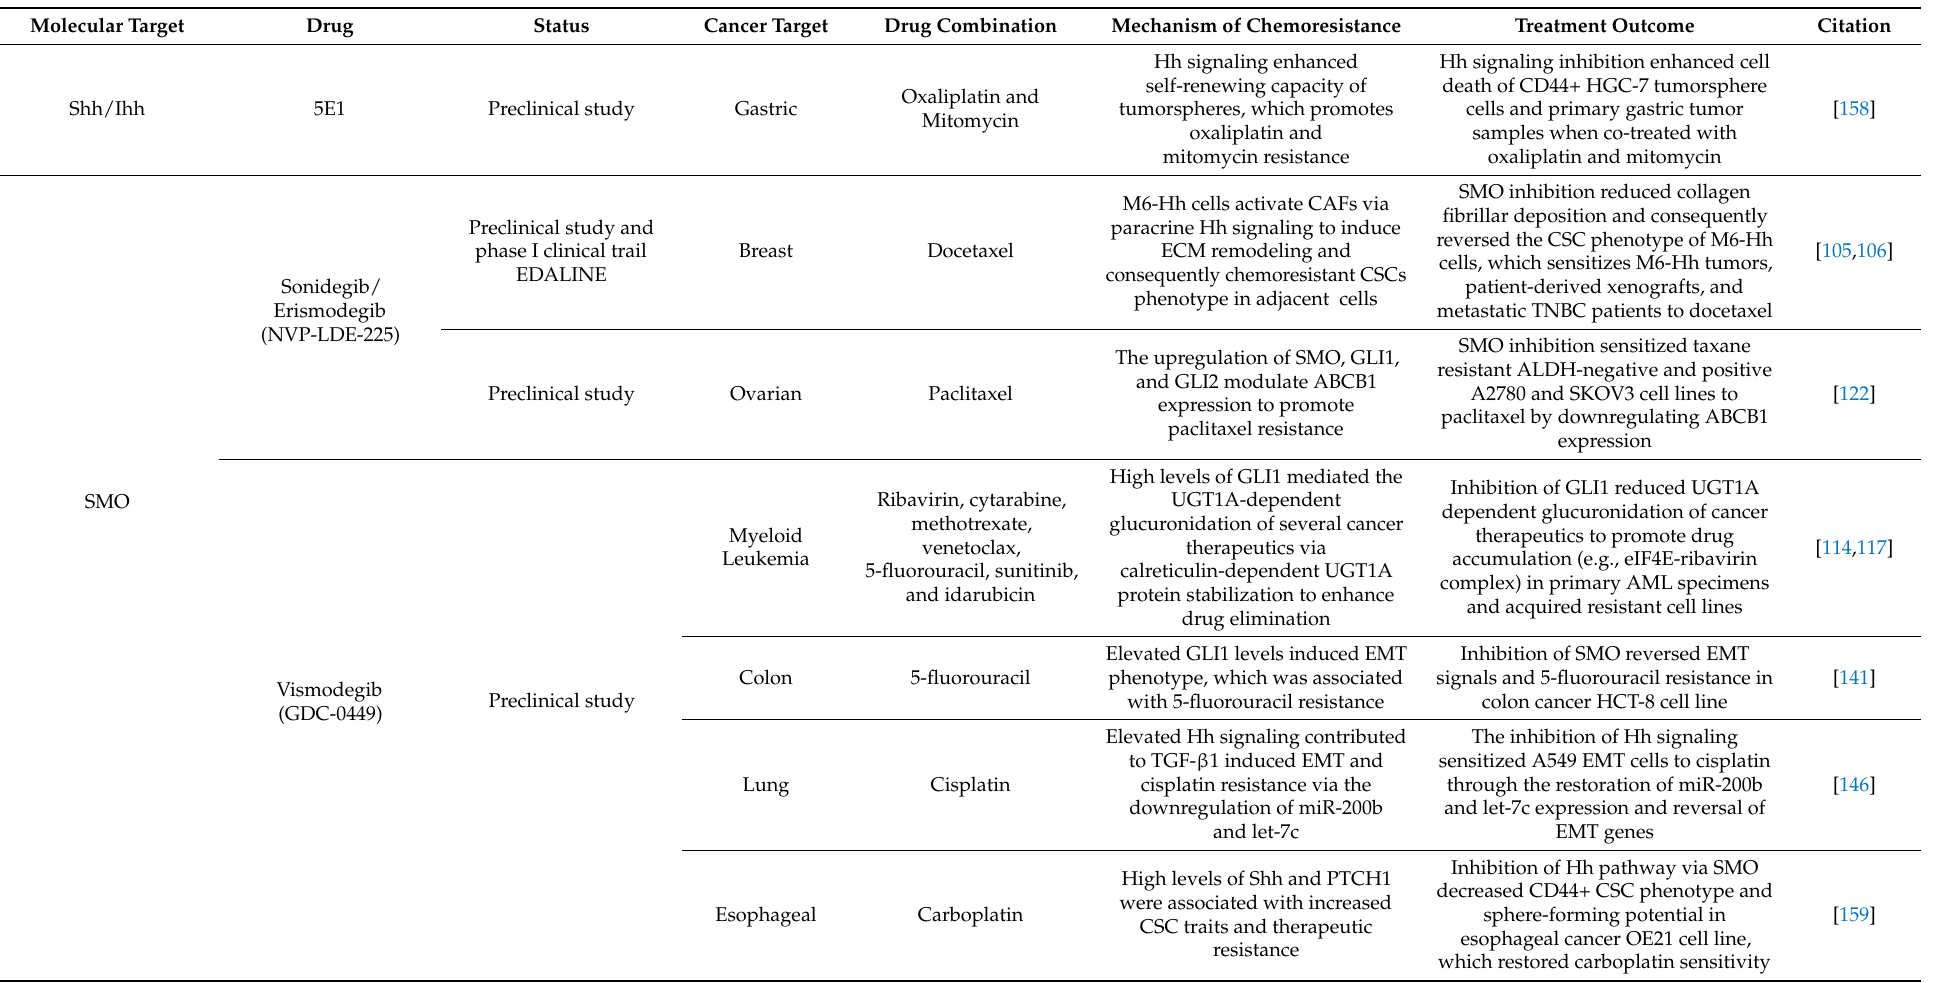
Table 1. Summary of the described studies on the Hh regulation of drug resistance mechanisms and the use of combination drug therapy involving Hh inhibitors and chemotherapeutic agents and its treatment